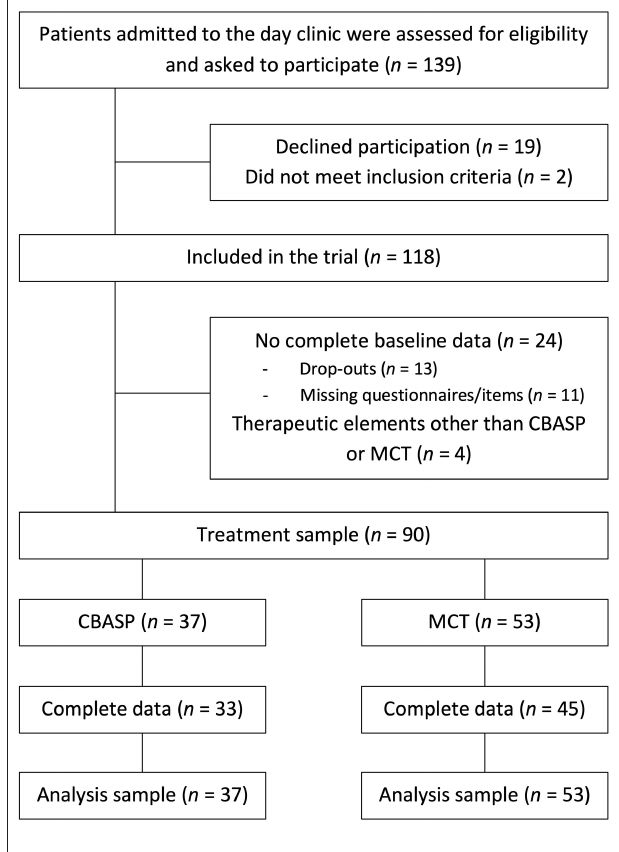
FIGURE 1 | Patient